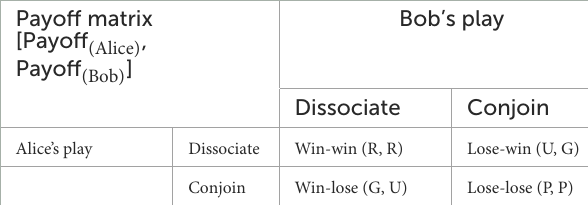
TABLE 3 Payoff matrix of Alice and Bob’s relationship in favor of